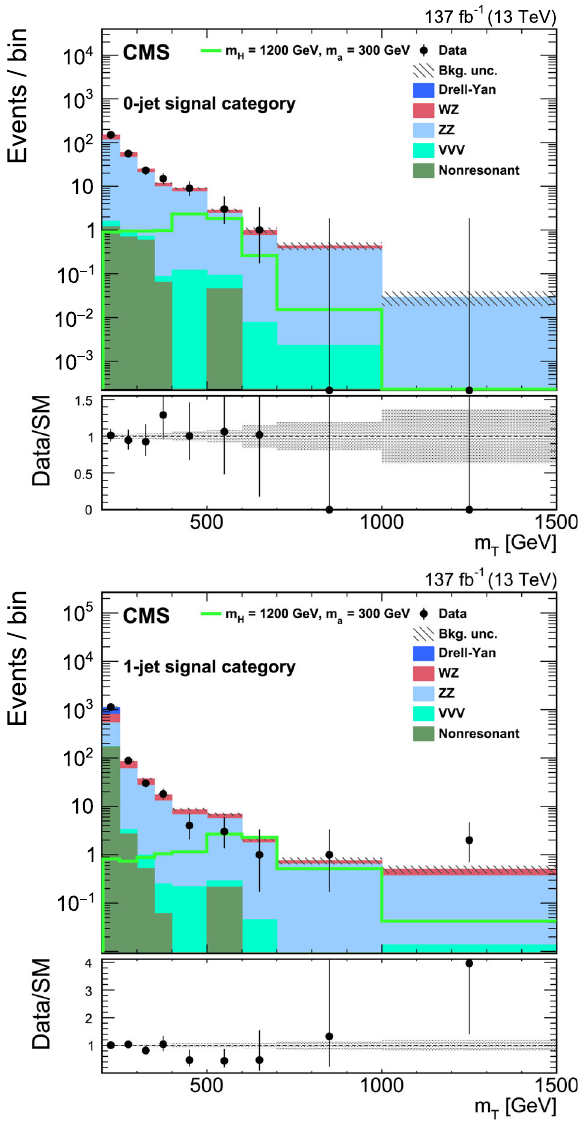
Fig. 4 The m T distributions for events in the signal region in the 0- jet (upper) and 1-jet (lower) categories. The rightmost bin includes all events with m T > 1000GeV. The uncertainty band includes both sta- tistical and systematic components. The signal normalization assumes the expected values for m H = 1200GeV , m a = 300GeV within the 2HDM+ a framework where m H = m H ± = m A , tan β = 1 and sin θ = 0 . 35